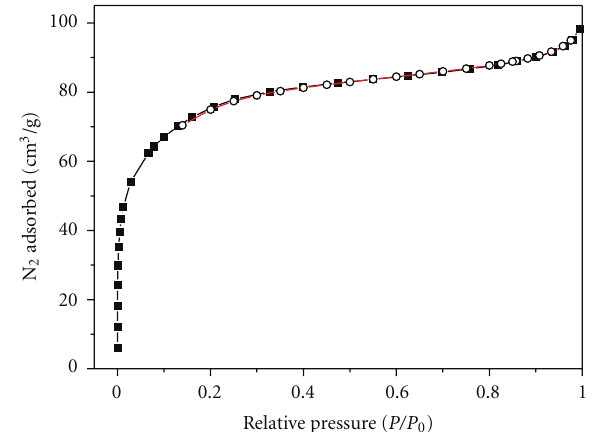
Figure 6: Nitrogen adsorption isotherms of APTMPP-MPS-TiO 2 .